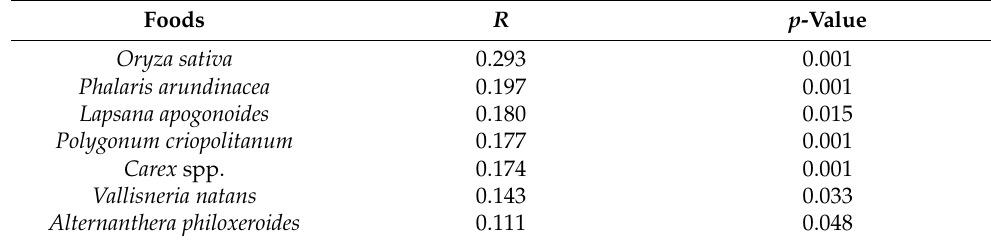
Table 3. Foods related to the composition of potential pathogenic bacteria in the faecal samples of hooded cranes according to Mantel